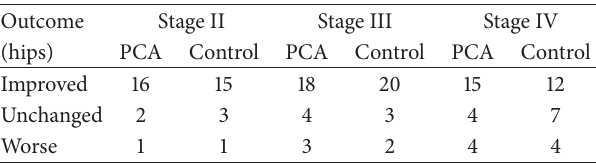
Table 3: Radiographic results in the postoperative corticosteroid administration group (PCA group) and the control